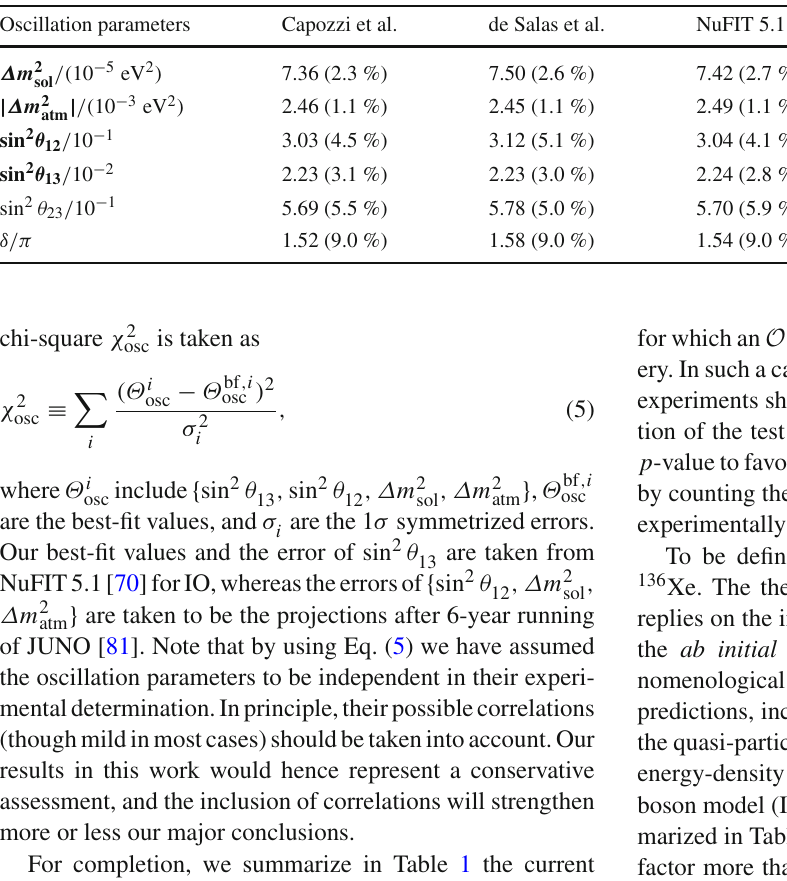
[68–70]. The last three columns give the prospective precision of future neutrino oscillation experiments JUNO [81], DUNE [44], and HK